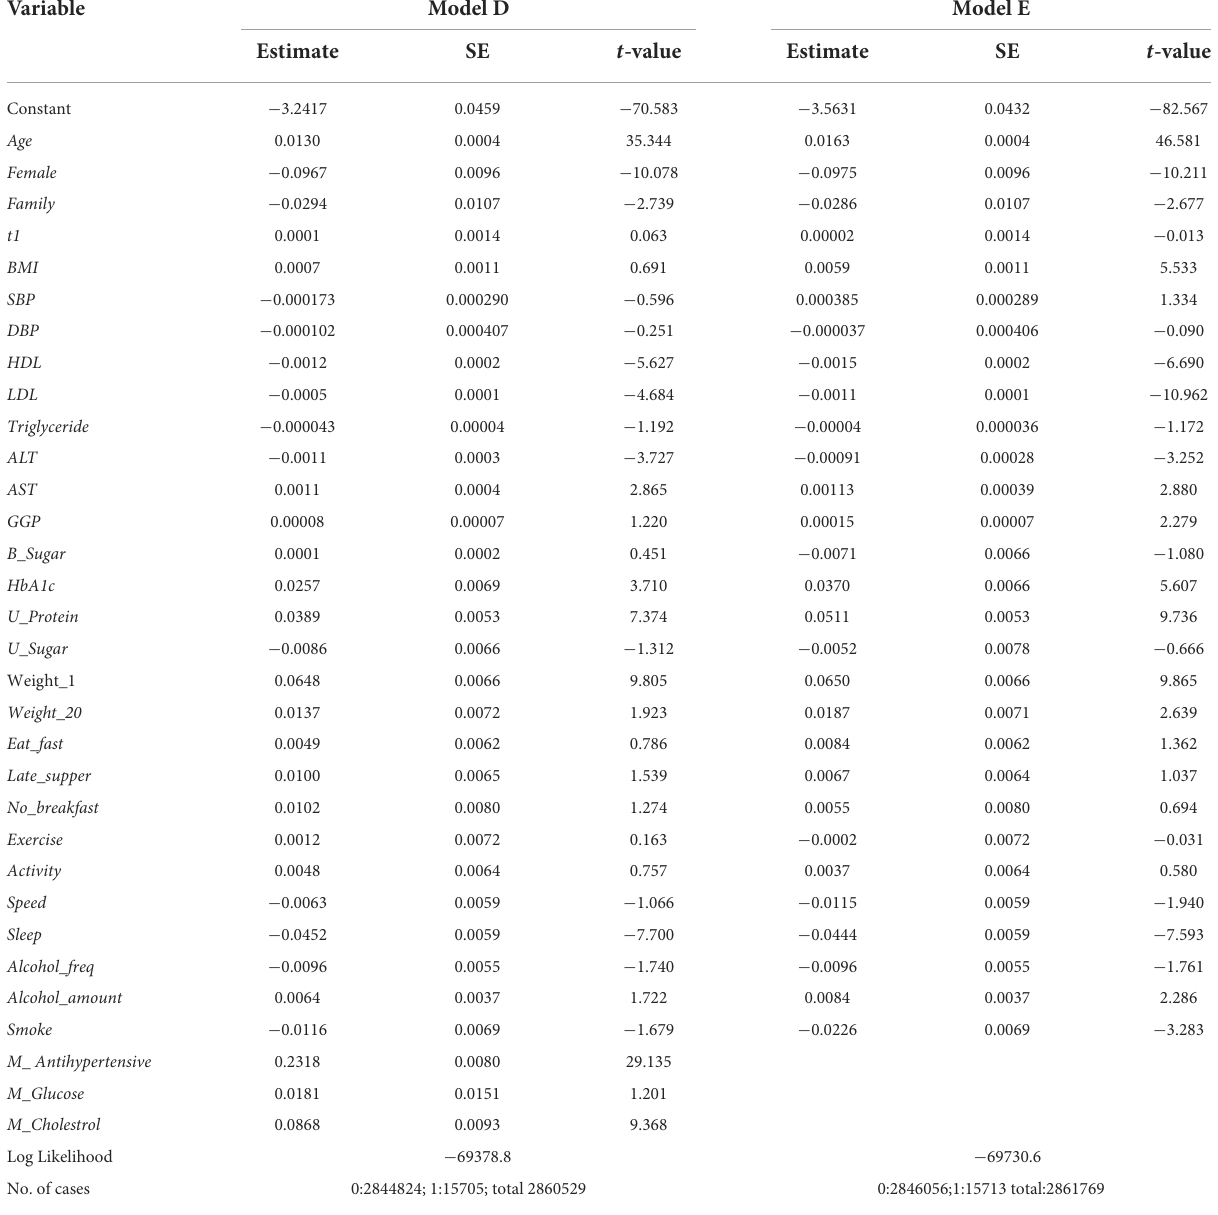
TABLE 5 Results of estimation: models D and